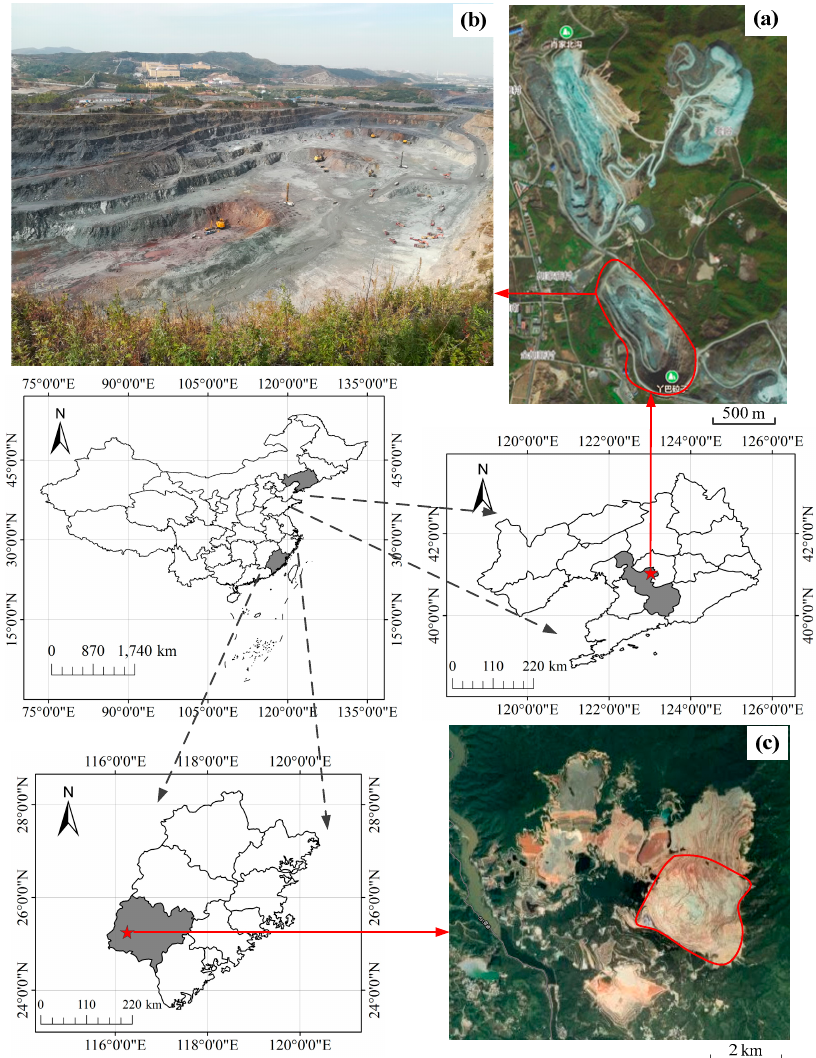
Figure 1. Study areas in terms of global geographic coordinates (WGS-1984). ( a , b ) The overview and in-site view of site A, and ( c ) overview of site B.